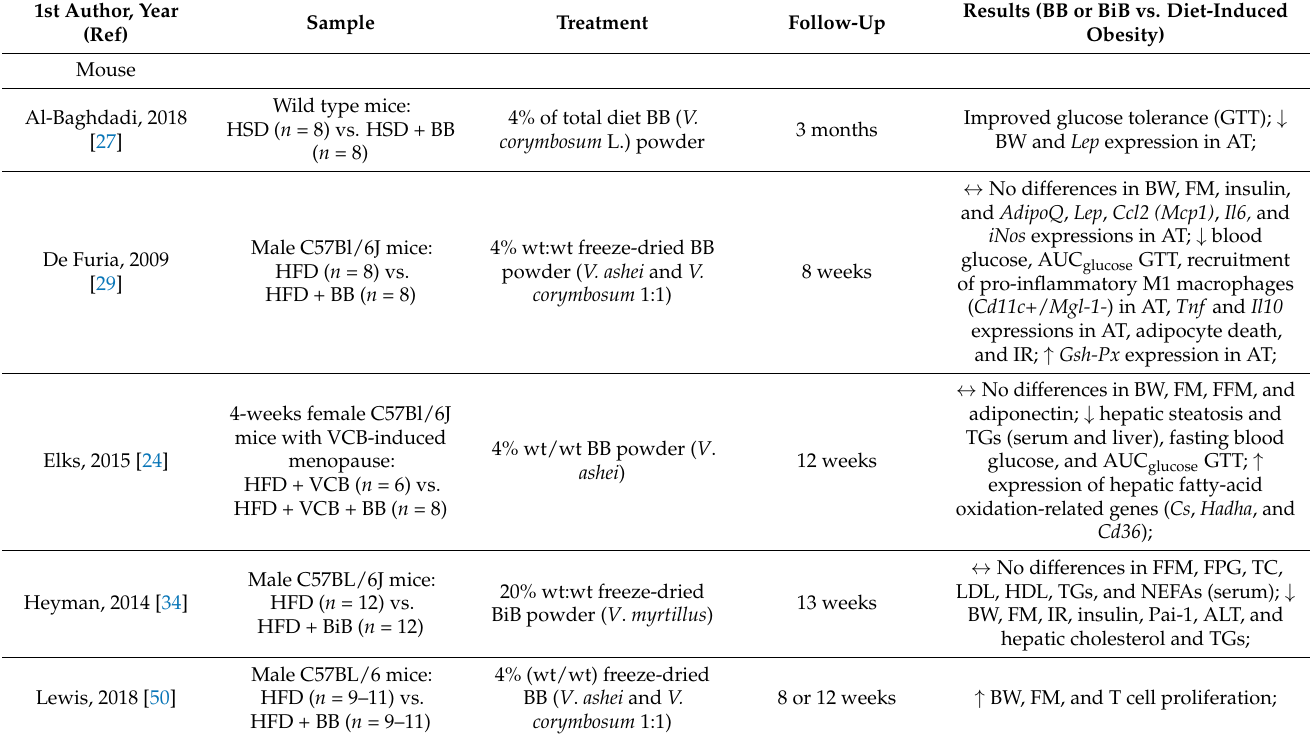
Table 3. Animal studies that evaluated the effect of blueberry or bilberry consumption in obesity and related-metabolic